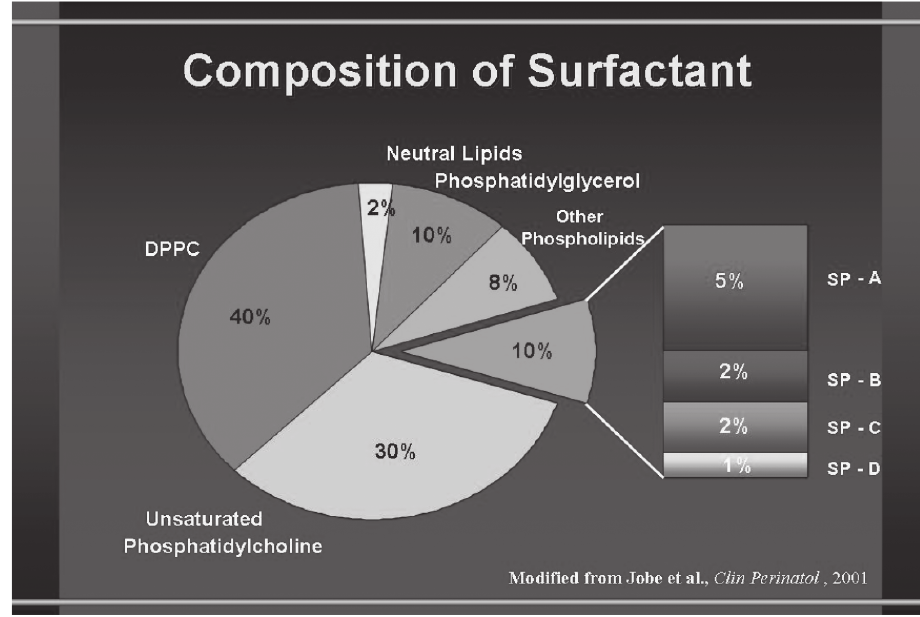
Figure 1 - Composition of surfactant. Modified from Jobe et al